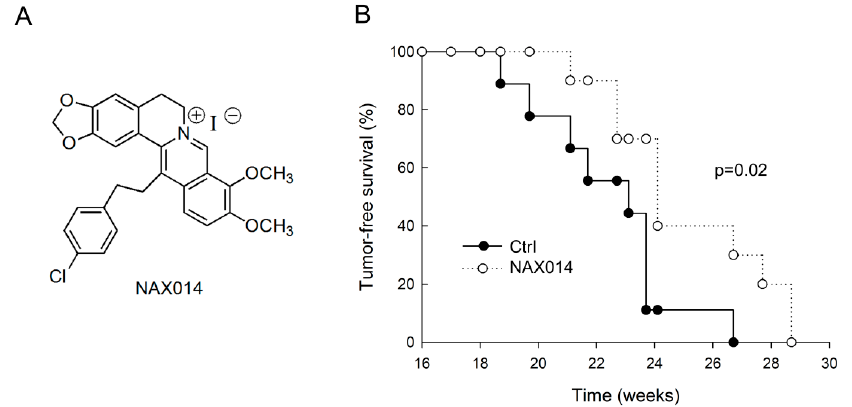
Figure 1. Effect of IG NAX014 administration on the kinetics of tumor growth in HER-2/neu transgenic mice. ( A ) Chemical structure of NAX014. ( B ) FVB/N HER-2/neu transgenic mice ( n = 10) were intragastrically administered two times a week with 20 mg/kg b.w. of NAX014 or vehicle alone (Ctrl) and analyzed for tumor incidence. The percentage of tumor-free mice was calculated as the cumulative number of mice with tumors and mice that were tumor-free. Kaplan–Meier analysis was performed to generate the tumor-free curves. Statistical significance ( p ) is reported in the text.